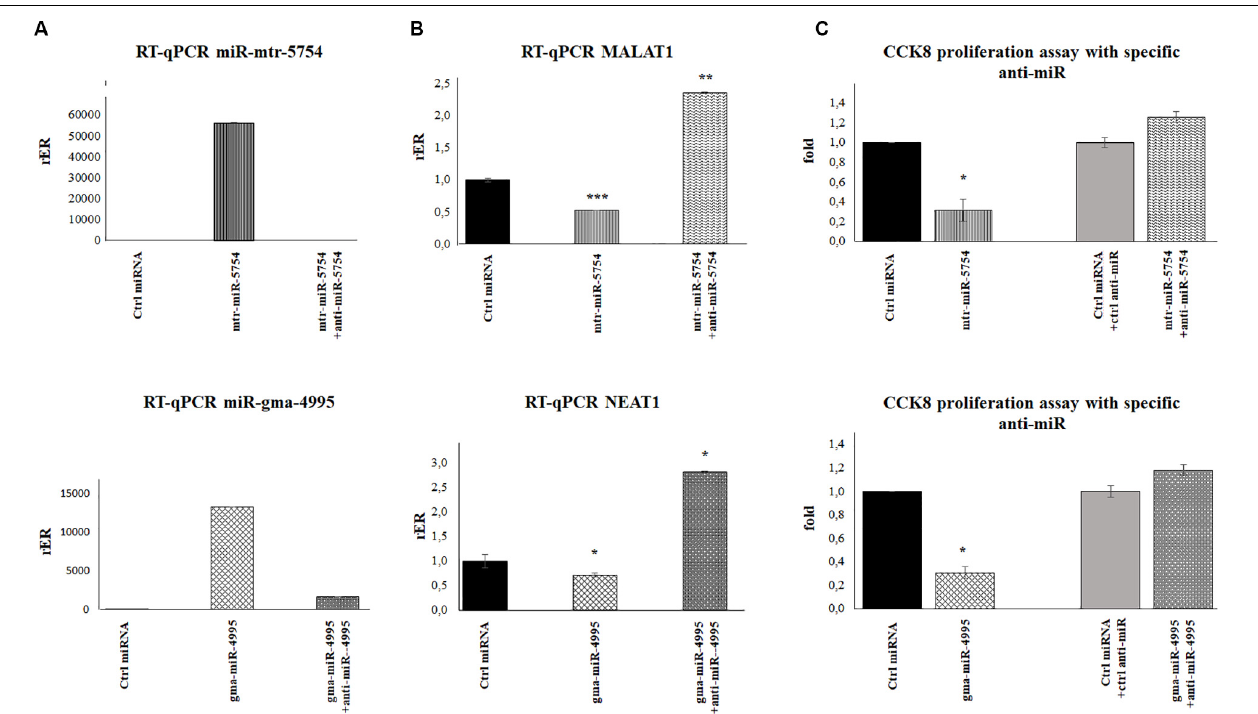
FIGURE 6 | Plant mtr-miR-5754 and miRgma-miR-4995 inhibitors reversed the effect of mtr-miR-5754 and miRgma-miR-4995 on metastasis-associated lung adenocarcinoma transcript 1 (MALAT1) and nuclear paraspeckle assembly transcript 1 (NEAT1) expression. (A) HCT116p53 − / − cells were transfected with control microRNA (miRNA), mtr-miR-5754, or gma-miR-4995 and after 24 h with anti-miR5754 or anti-miR4995, respectively, which suppressed the plant miRNA levels in the cells. (B) Reverse transcription quantitative PCR (RT-qPCR) of MALAT1 and NEAT1 in HCT116p53 − / − cells transfected with control miRNA, mtr-miR-5754, or gma-miR-4995 and after 24 h with anti-miR5754 or anti-miR4995, respectively (* p < 0.05; ** p < 0.005; and *** p < 0.0005). (C) Cell Counting Kit-8 (CCK-8) assay of HCT116p53 − / − cells transfected with control miRNA, mtr-miR-5754, or gma-miR-4995 and after 24 h with anti-miR5754 or anti-miR4995,